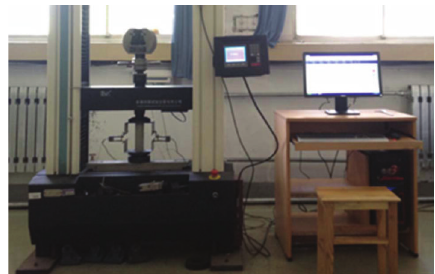
Figure 1: The test